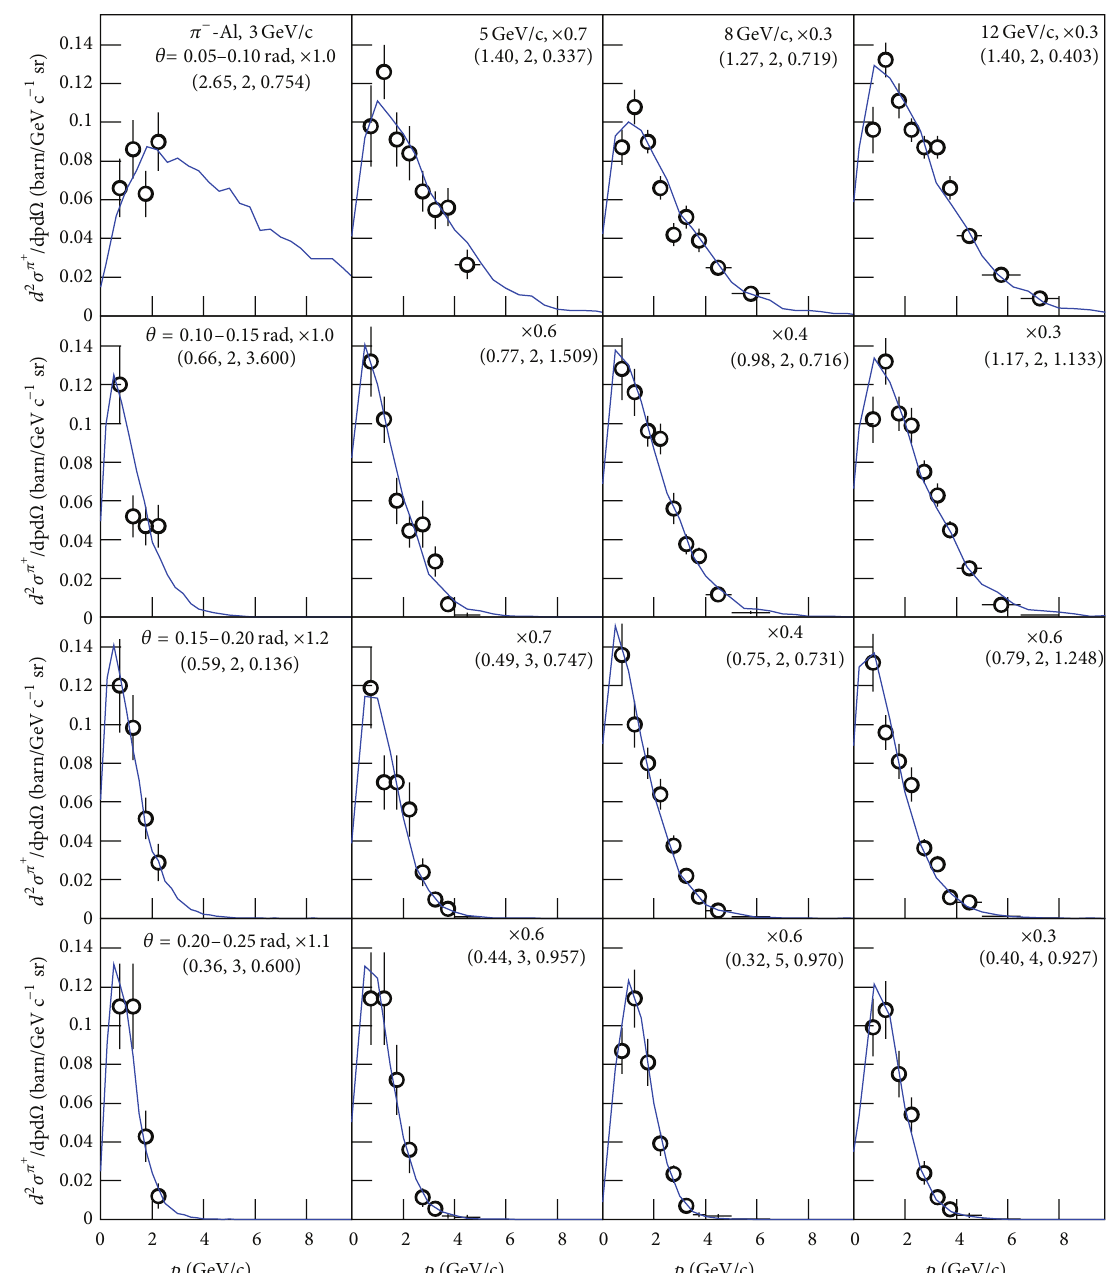
Figure 9: The same as Figure 1, but showing the results for 𝜋 + production cross sections in 𝜋 − -Al